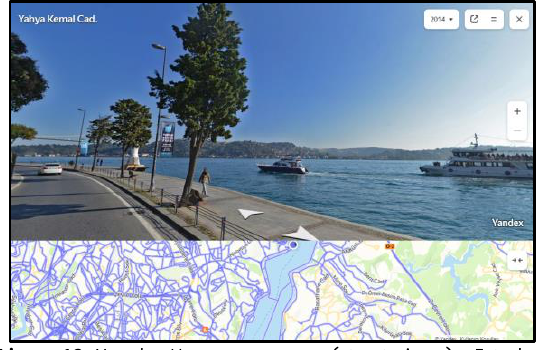
Figure 13. Yandex Maps panoramas (street views) – Istanbul.